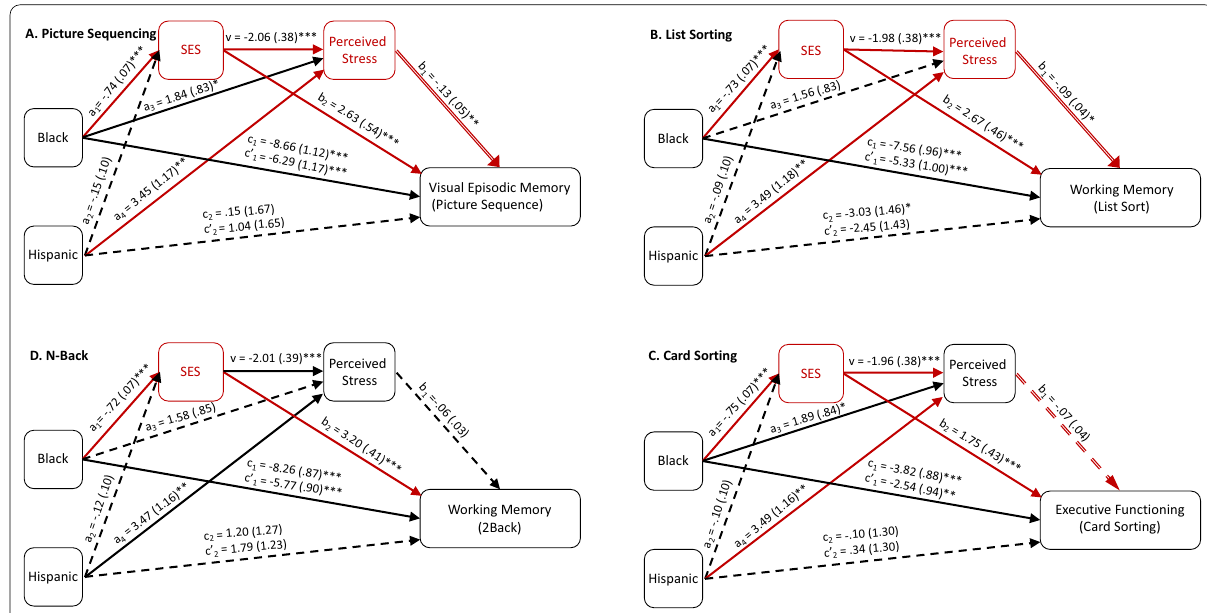
Fig. 4 Sequential mediation analyses for picture sequencing ( A ), list sorting ( B ), card sorting ( C ), and the N‑back ( D ). Socioeconomic status (SES) predicted perceived stress, which in turn predicted ethnoracial disparities in cognition for the picture sequence task and the working memory task, but not the other two. An independent SES predicted ethnoracial disparities in cognition for all four cognitive tasks. Unstandardized parameter estimates and standard errors are shown for each pathway. Asterisks denote significant pathways for one ethnoracial minority with a single line and for both ethnoracial minorities with a double line: * p < .05, ** p < .01, *** p < .001. Dashed lines represent non‑significant pathways. Red lines = = = and text represent significant mediating